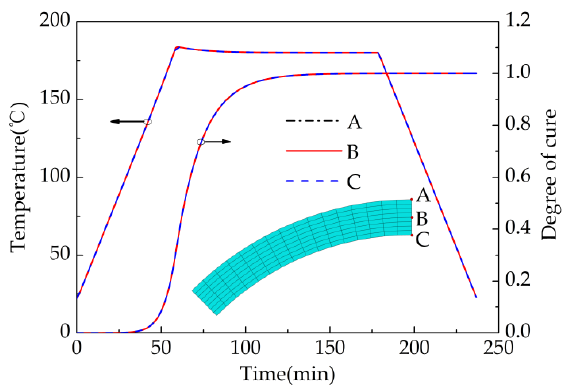
Figure 5. Predicted development of through-thickness temperature and cure degree for an eight-layer part during curing.